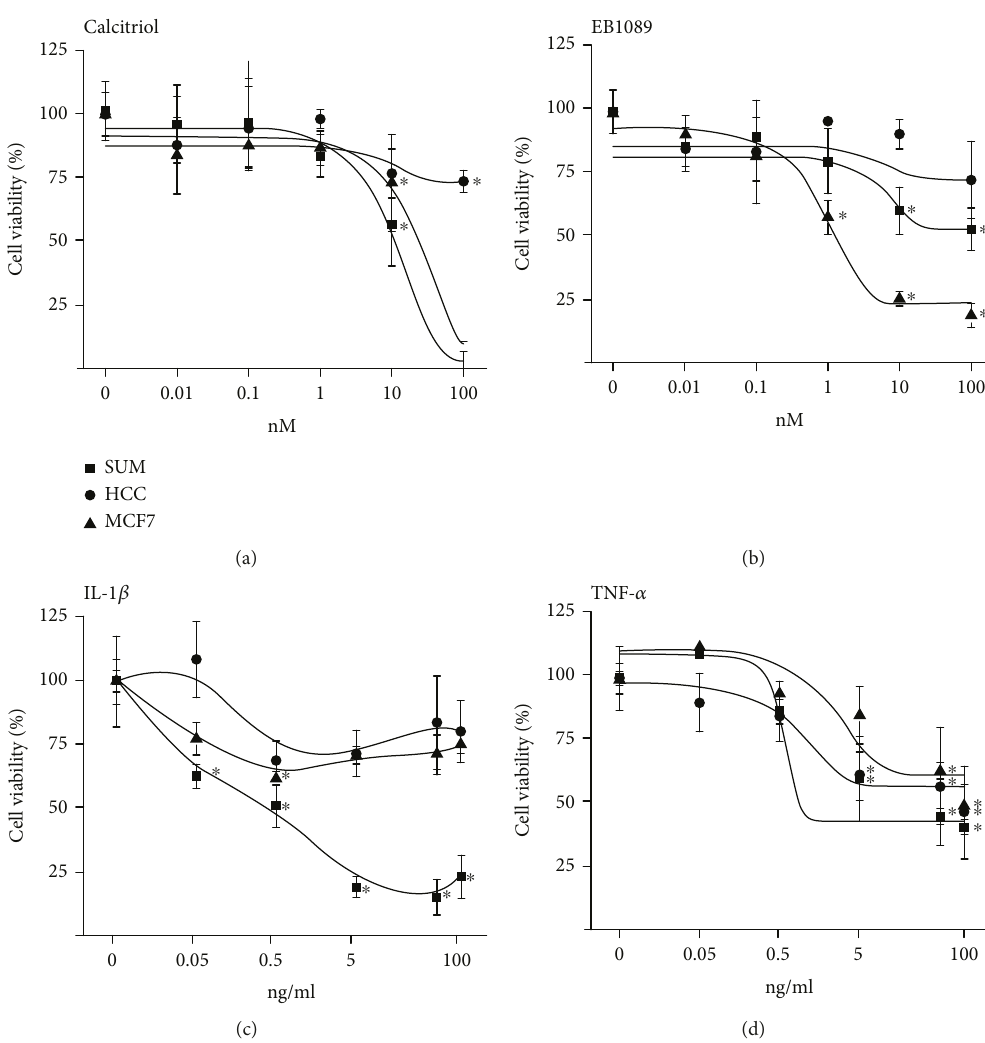
Figure 2: Calcitriol, EB1089, IL-1 β , and TNF- α e ff ect on breast cancer cell proliferation. SUM-229PE ( ■ ), HCC1806 ( ● ), and MCF7 ( ▲ ) cells were cultured in the absence (0) or presence of di ff erent concentrations of calcitriol (a), EB1089 (b), IL-1 β (c), or TNF- α (d) during 6 days. Then, cell proliferation was evaluated by the XTT method. The results represent the average of 3 experiments, each in triplicate ± SD . ∗ P < 0 05 vs. control. Nontreated cells were considered as 100% of cell proliferation. Ethanol was used as vehicle of calcitriol and EB1089 and phosphate-bu ff ered saline solution (PBS) for